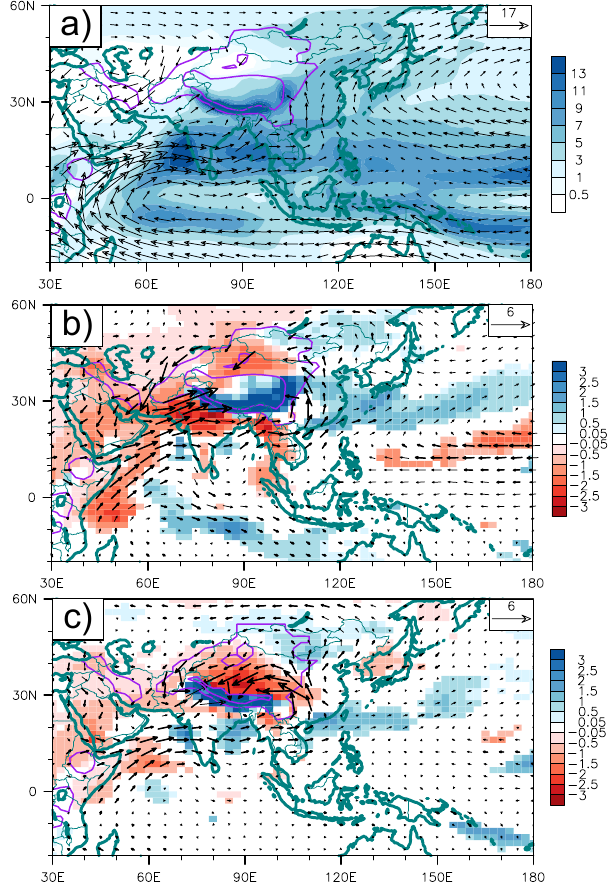
Figure 2. JJA climatology of surface wind (ms − 1 ) and precipita- tion (mmday − 1 ) for FULL_TP (a) and JJA differences in surface wind (ms − 1 ) and precipitation (mmday − 1 ) for FULL_TP minus NO_TP (b) and BARRIER minus NO_TP (c) . Blue indicates pos- itive values, red indicates negative values of precipitation change. Only significant values are shown for precipitation (color shading). Bold vectors indicates the significant changes in wind. Purple con- tour lines denote the elevations of 1200 and